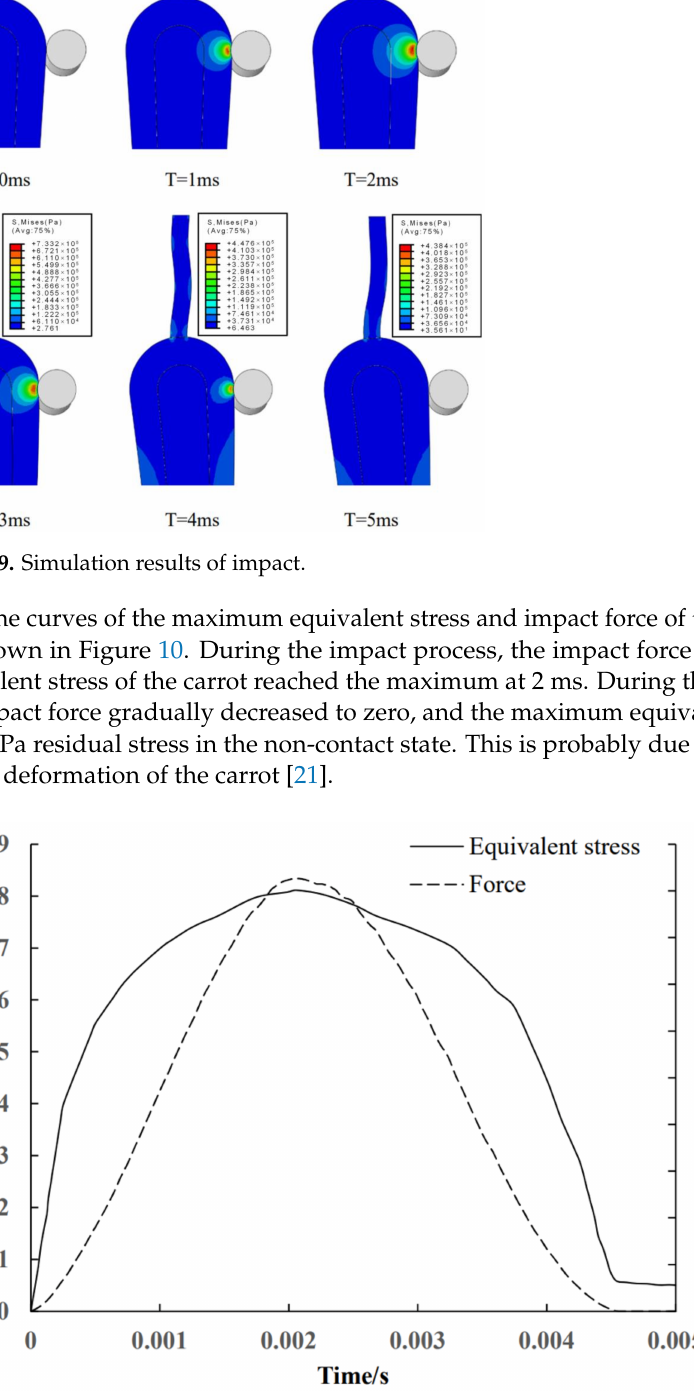
Figure 10. Curves of equivalent stress and impact force changing with